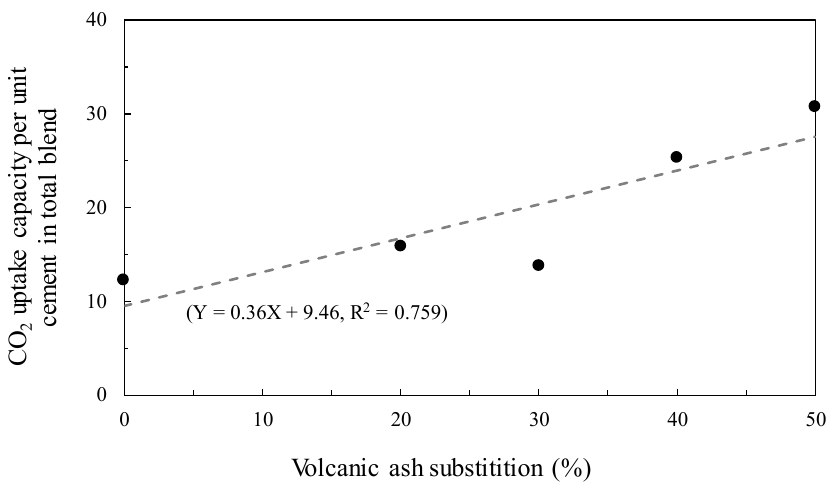
Figure 6. Relationship between CO 2 uptake capacity per unit cement in the total blend of volcanic ash-blended PC and amount of volcanic ash substitution.